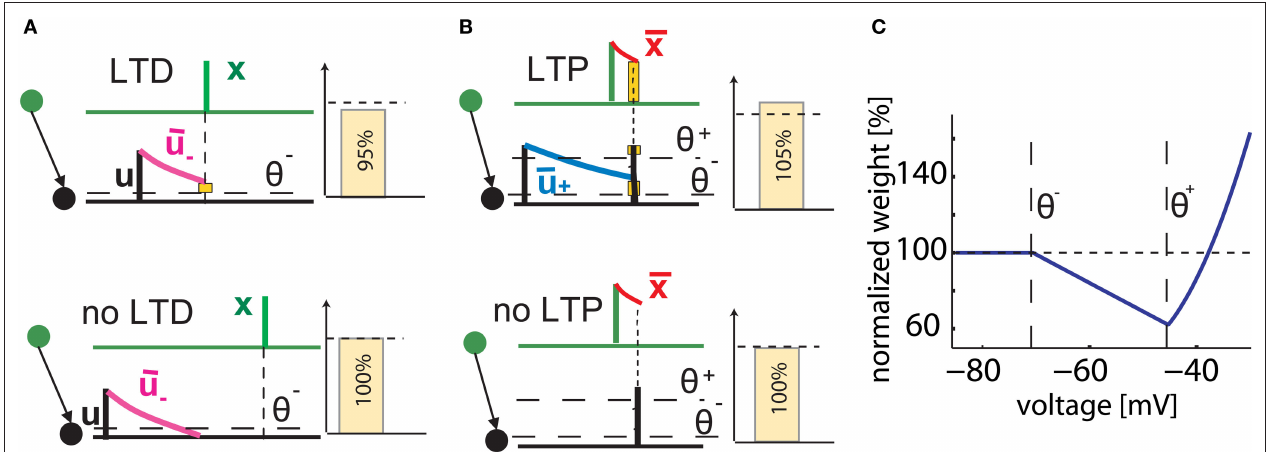
FigurE 1 | Schematics of the model. (A) LTD occurs at the time of a above θ (dashed line). The three conditions are met at the moment of the − presynaptic spike (green) if the low-pass filtered voltage trace u (magenta) is second postsynaptic spike in a post-pre-post triplet (top panel), but not after a − above θ (dashed line). The amount of LTD is proportional to the size of the single pre-post pair (bottom). The amount of plasticity is proportional to the − yellow box. If the timing difference between post- and presynaptic spikes is too multiplication of the yellow boxes. (C) Presynaptic stimulation under voltage big, no LTD is induced (bottom). (B) LTP requires three factors: a momentary clamp conditions shows the relevance of the threshold θ for onset of LTD and − voltage u (black) above θ (dashed line), the trace x (red) left from a previous for the onset of the LTP contribution. LTP becomes dominant if the voltage is θ + + presynaptic spike above 0, and the trace u (blue) of the low-pass filtered voltage 10 mV or more above θ . + +